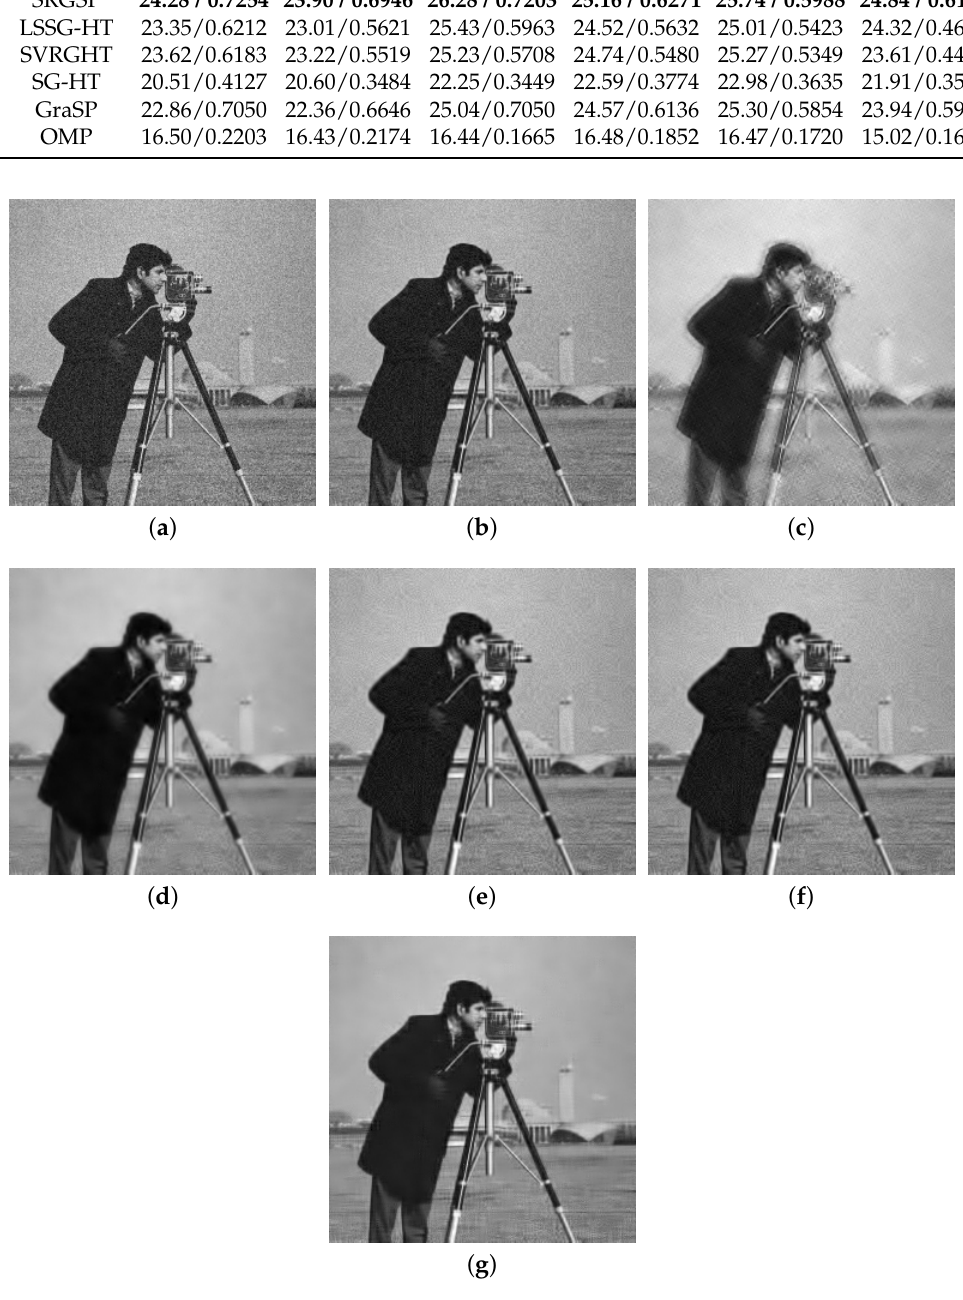
Figure 3. Comparison of the denoising results (PSNR/SSIM) of all the algorithms on the standard cameraman image with σ = 15, where s = 10. ( a ) Noise image ( σ = 15); ( b ) OMP (27.62/0.6006); ( c ) SG-HT (22.90/0.7308); ( d ) GraSP (23.50/0.8453); ( e ) SVRGHT (27.96/0.8588); ( f ) LSSG-HT (27.26/0.8433); ( g ) SRGSP